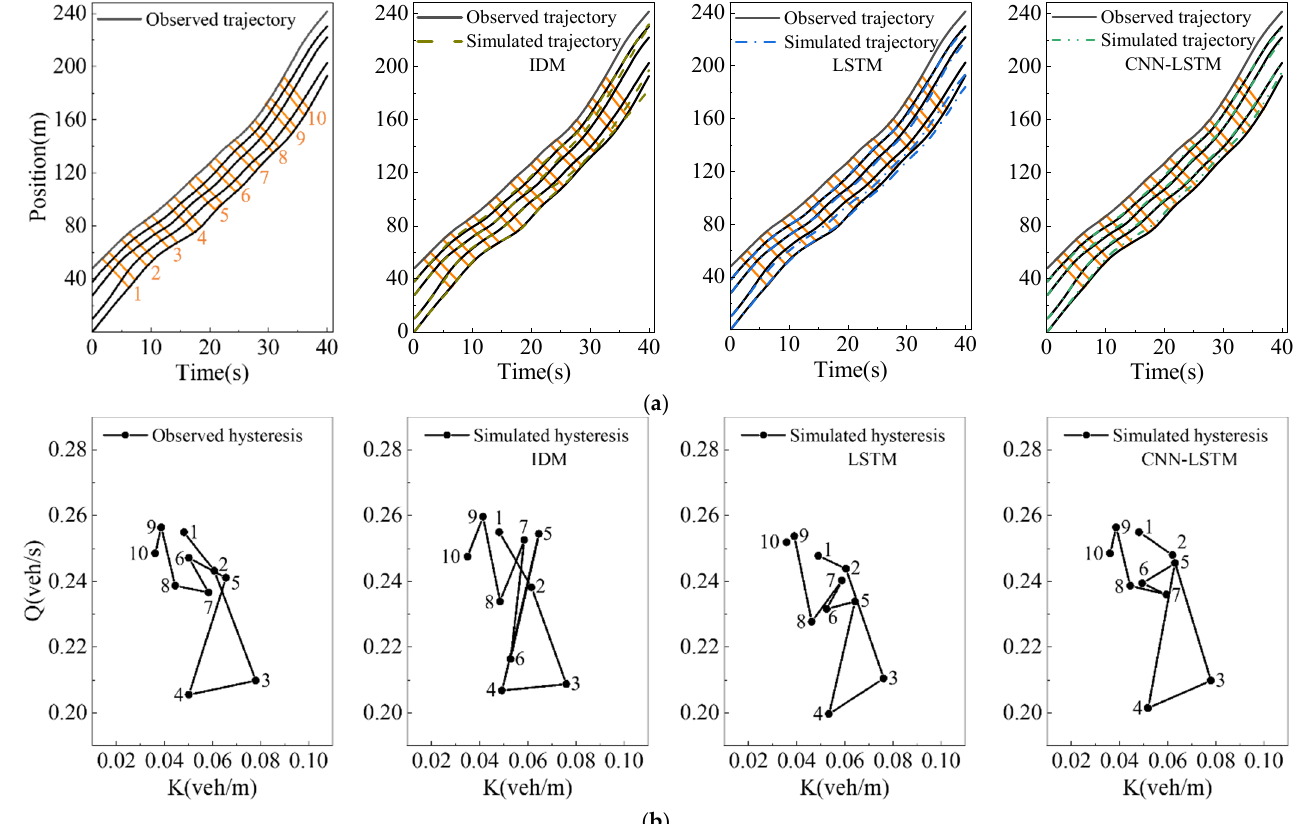
Figure 9. Platoon simulation in congested traffic flow, where ( a ) is the trajectory comparison, ( b ) is the flow ‐ density diagram, respectively.